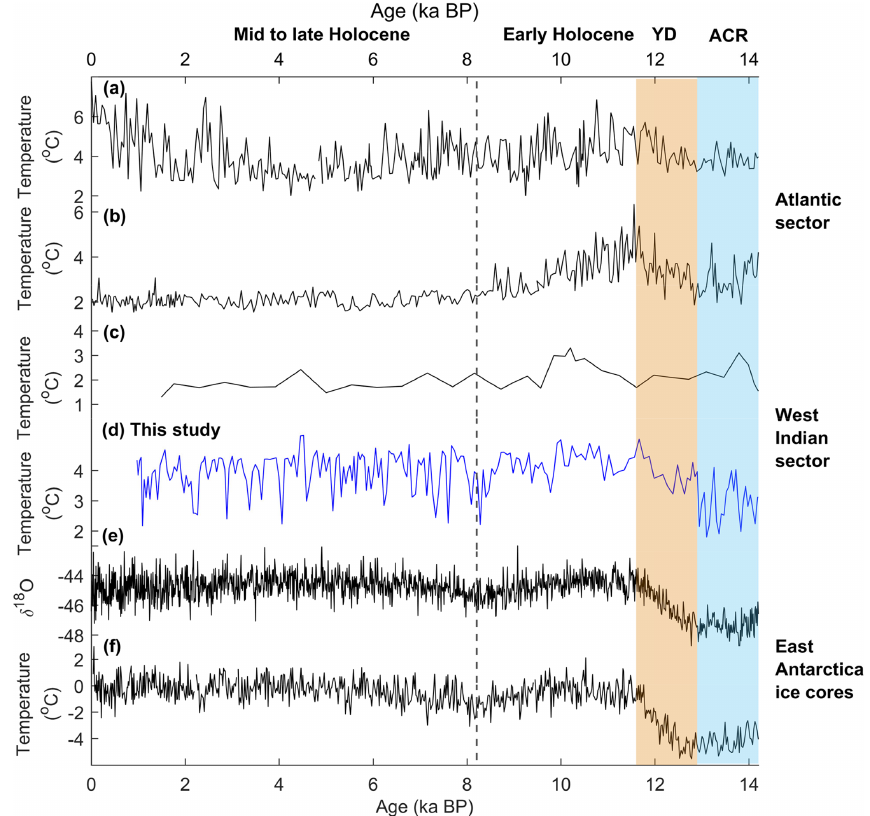
Figure 7. Reconstructions reflecting temperature since 14.2ka from the Southern Ocean and Antarctica at locations shown in Fig. 1. (a) TN057-17-PC1 diatom-based SST reconstruction (Nielsen et al., 2004); (b) TN057-13-PC4 diatom-based SST reconstruction (Anderson et al., 2009; Divine et al., 2010); (c) PS2606-6 diatom-based SST reconstruction from the Conrad Rise (Xiao et al., 2016); (d) COR1GC SST reconstruction (this study) from the Conrad Rise; (e) EDML ice core δ 18 O reconstruction (EPICA Community Members, 2006); (f) EDC ice core temperature reconstruction (Jouzel et al.,